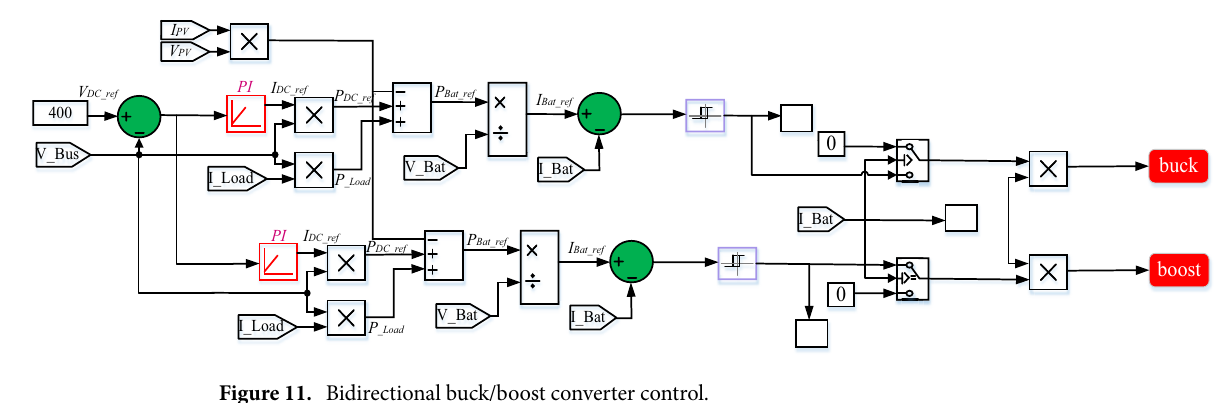
Figure 11. Bidirectional buck/boost converter